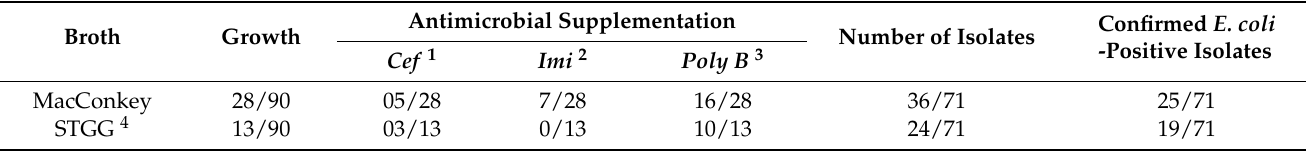
Table 3. Positive cloacal swabs and number of E. coli -confirmed samples from Psittaciformes under captivity at the Centro de Triagem de Animais Silvestres da Para í ba (CETAS-PB), located in the Restinga de Cabedelo National Forest, Brazil. Antimicrobial Supplementation Broth Growth Imi